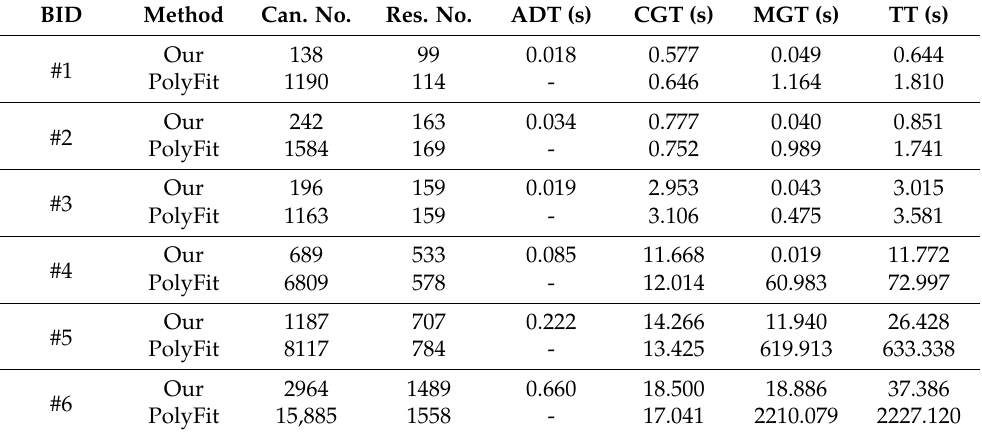
Table 2. Quantitative statistics on data and computation cost. BID: Building ID; Can. No.: Number of Candidate faces; Res. No.: Number of resulting faces; ADT: Time for adjacency estimation; CGT: Time for candidate generation; MGT: Time for resulting Model Generation; TT: Total time.